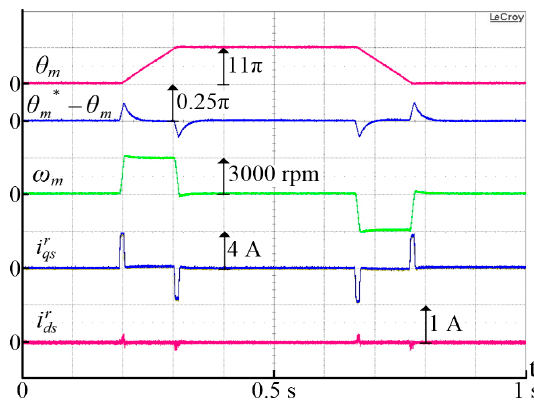
Figure 22. Speed, position, and current waveforms when the motor is controlled in the positioning mode.